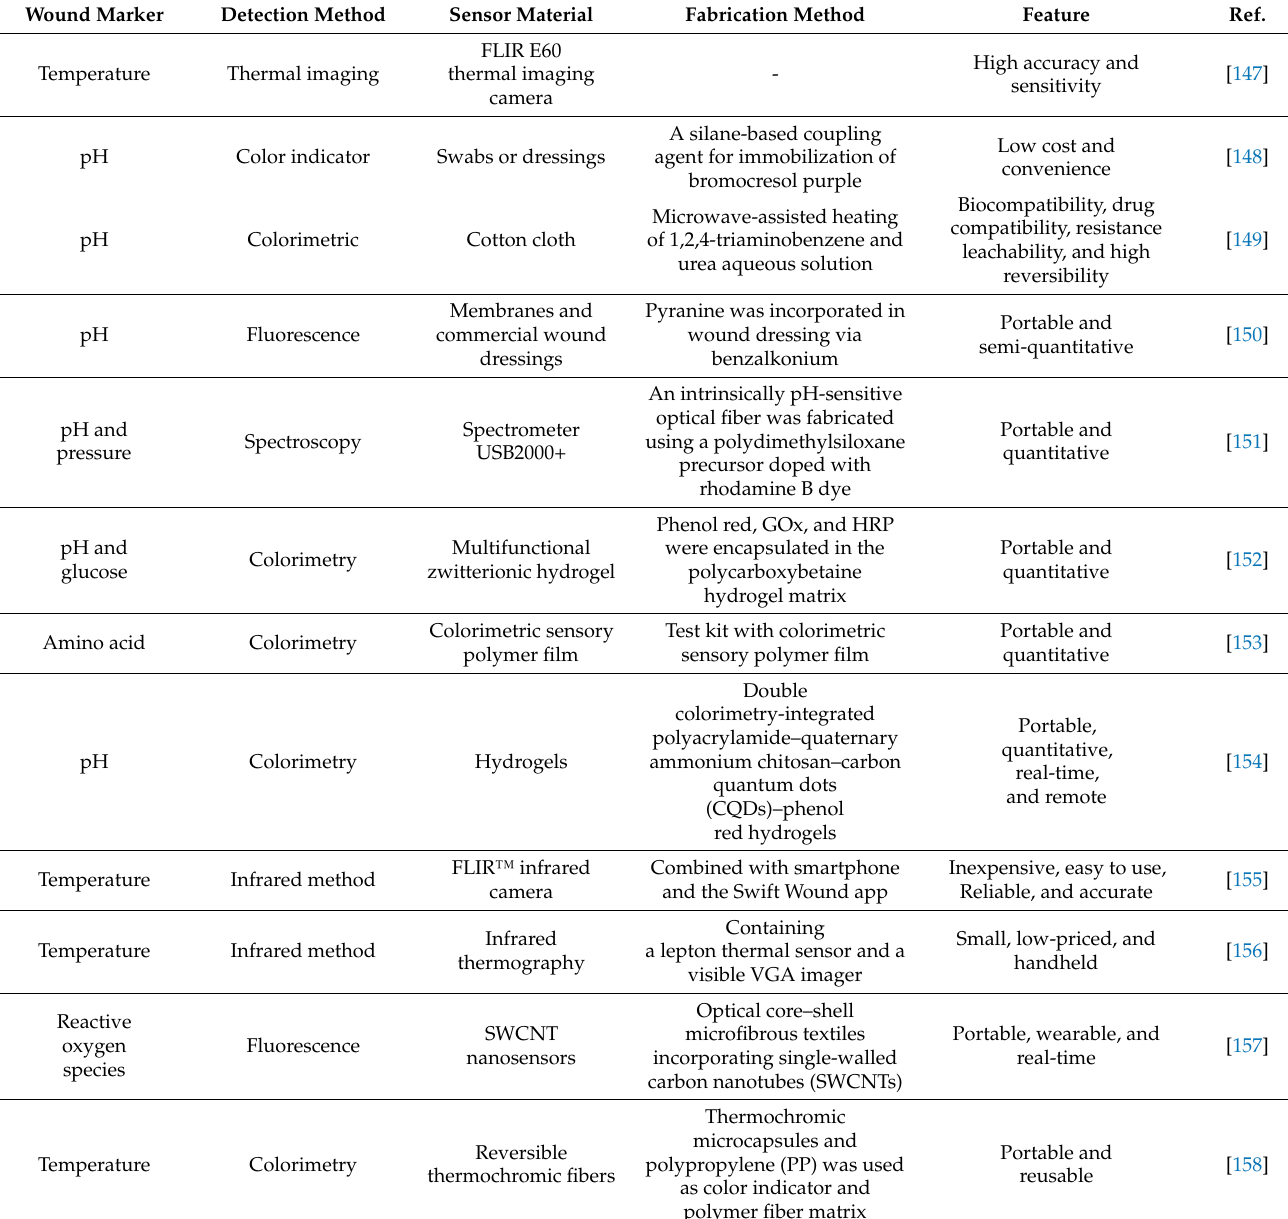
Table 3. The detection methods, sensor materials, fabrication methods, and features of the flexible wearable sensors for wound detection with the optical detection principle mentioned in this